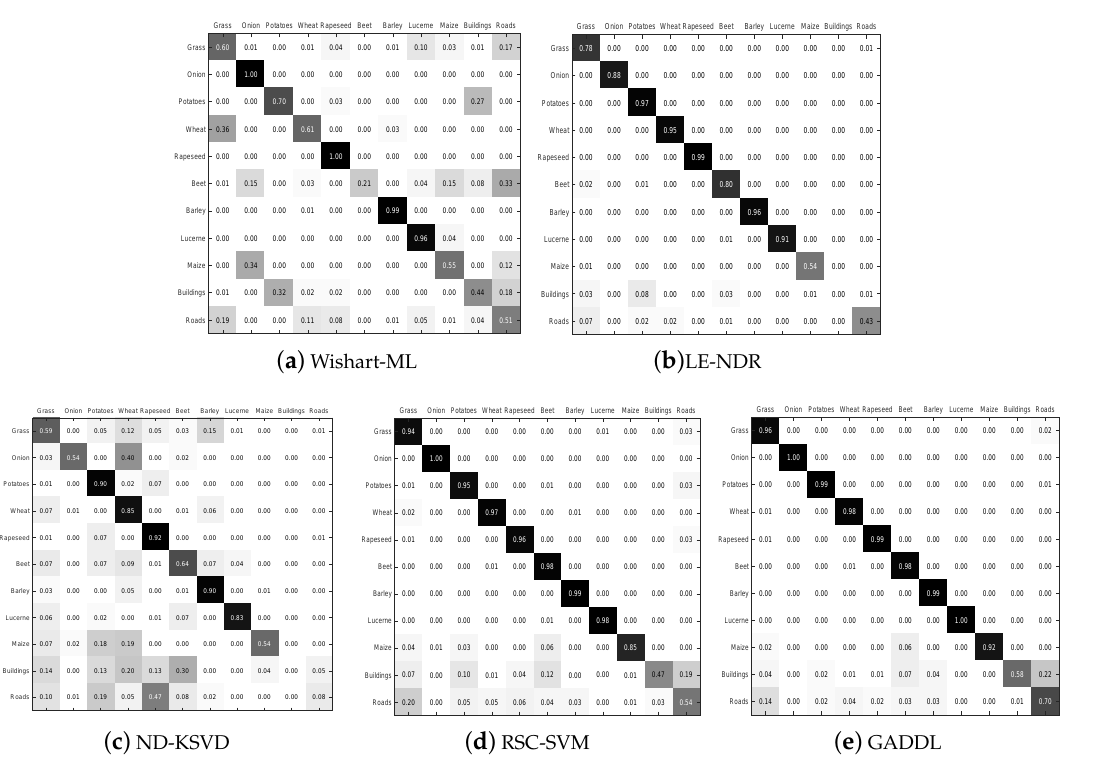
Figure 8. Confusion matrixes of classification under different